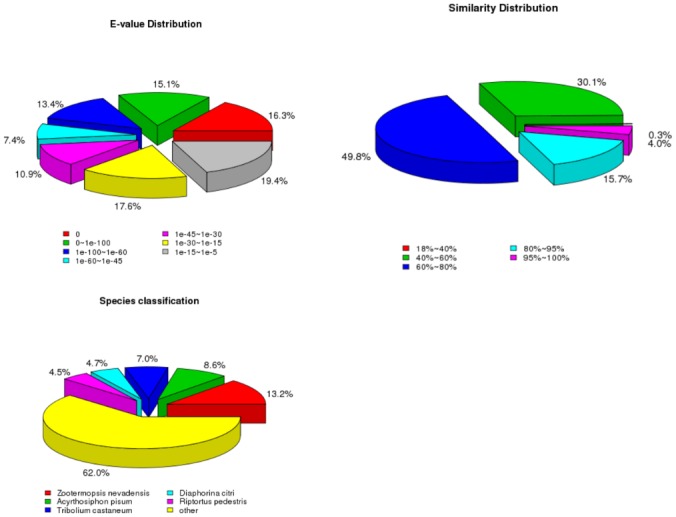
Pie charts showing distribution of the BLASTxmatches of C. Ciliata transcriptome unigenes against Nr databases.(a) E-values distribution, (b) similarity distribution, and (c) species classification.